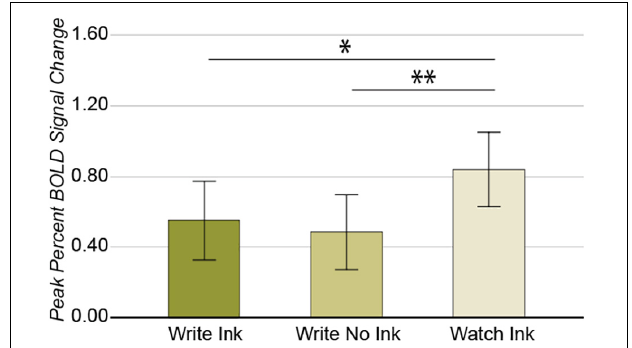
FIGURE 3 | Left anterior fusiform gyrus. Main effect of CONDITION. Error bars represent 95% confidence intervals. ∗∗ p < 0.01; ∗ p < 0.05.